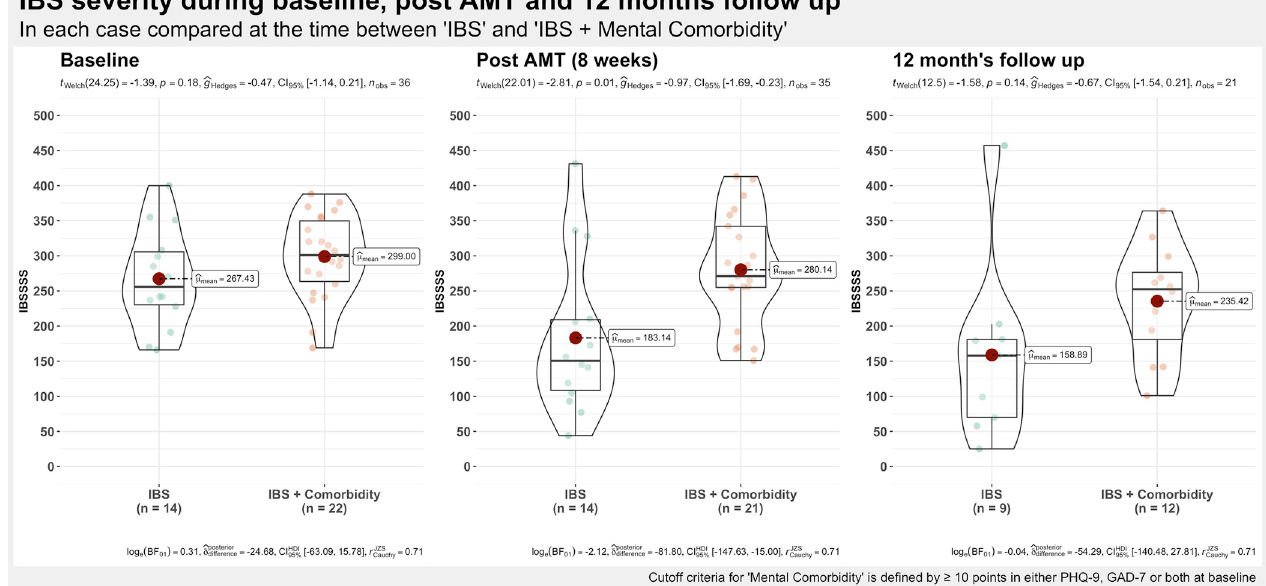
Fig 2. IBS severity syndrome at baseline, post-AMT and follow-up for both groups: No mental comorbidity and with mental comorbidity (depression and anxiety). https://doi.org/10.1371/journal.pone.0277880.g002 Table 2. At the 12 month follow-up, both groups improved their severity scores but also con- verged at the same time (mean in the no mental comorbidity group = 158.89, mean in the